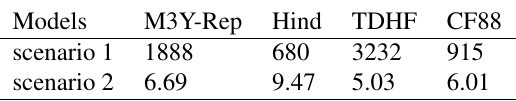
Table 1. The reduced- χ 2 for di ff erent models (scenario 1: No normalization; scenario 2: